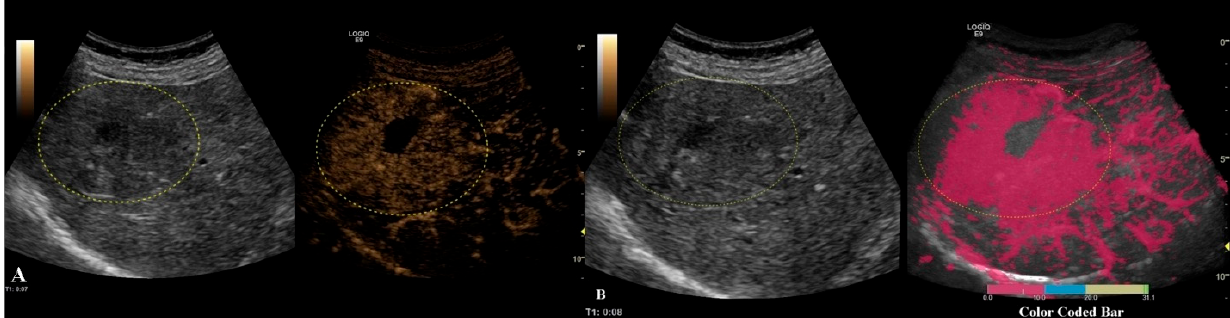
Figure 6. Arterial phase of CEUS is depicted in frame ( A ). In frame ( B ), parametric imaging was applied, thus better documenting the arrival time of bubbles by using color coding, as shown in the color-coded bar.